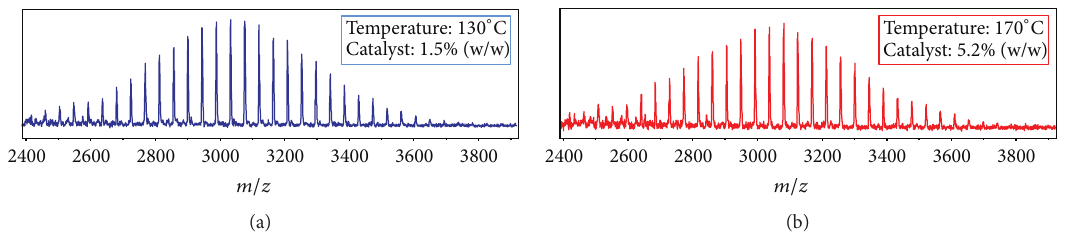
Figure 3: Polyglycerol molecular weight distributions determined with MALDI-TOF spectra of two samples. (a) Polyglycerol synthesized at 130 ∘ C and 1.5% (w/w) catalyst concentration and (b) polyglycerol synthesized at 170 ∘ C and 5.2% (w/w) catalyst concentration.